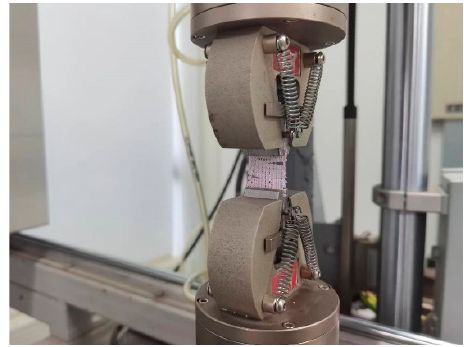
Figure 2. Photographs of the tensile performance test